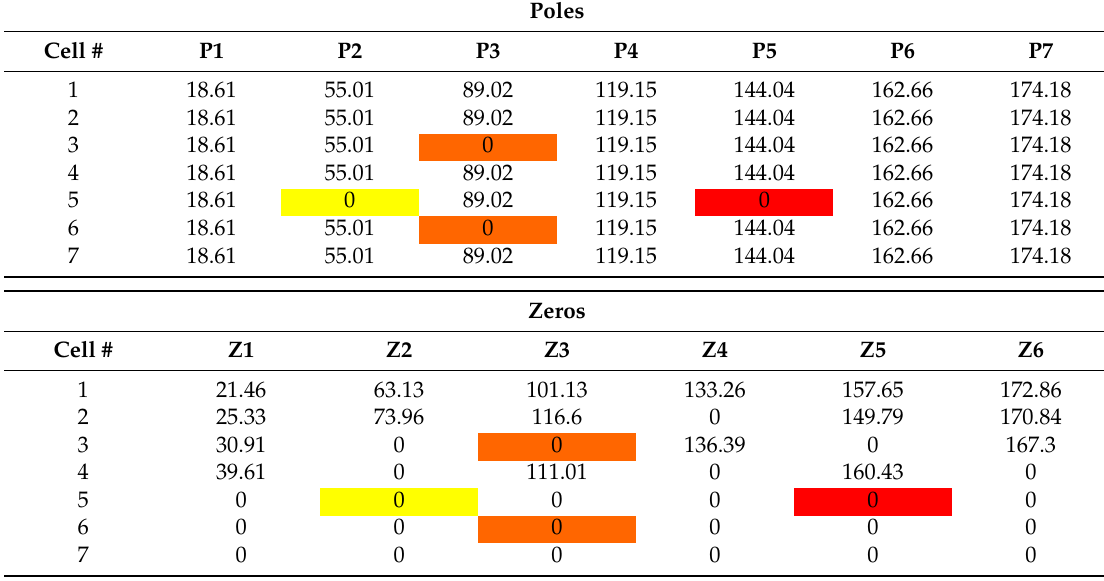
Table 2. Array of the poles and zeros (in KHz) of the transfer function of the circuit in Figure 6. The colors used for some of the ‘zero’ values reported in the cells are here used to put in evidence the cancellation action of zeros and poles coincidence; thus, each couple of identical color (orange. red. yellow) corresponds to a couple of coincident pole–zero.